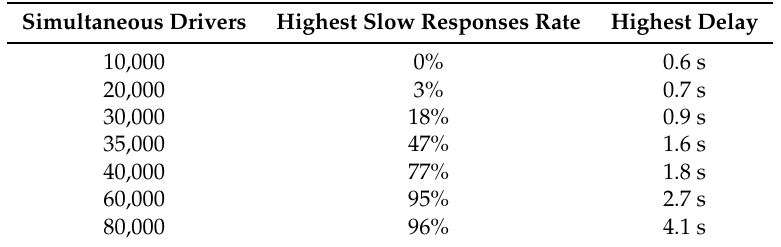
Table 3. Number of simultaneous users